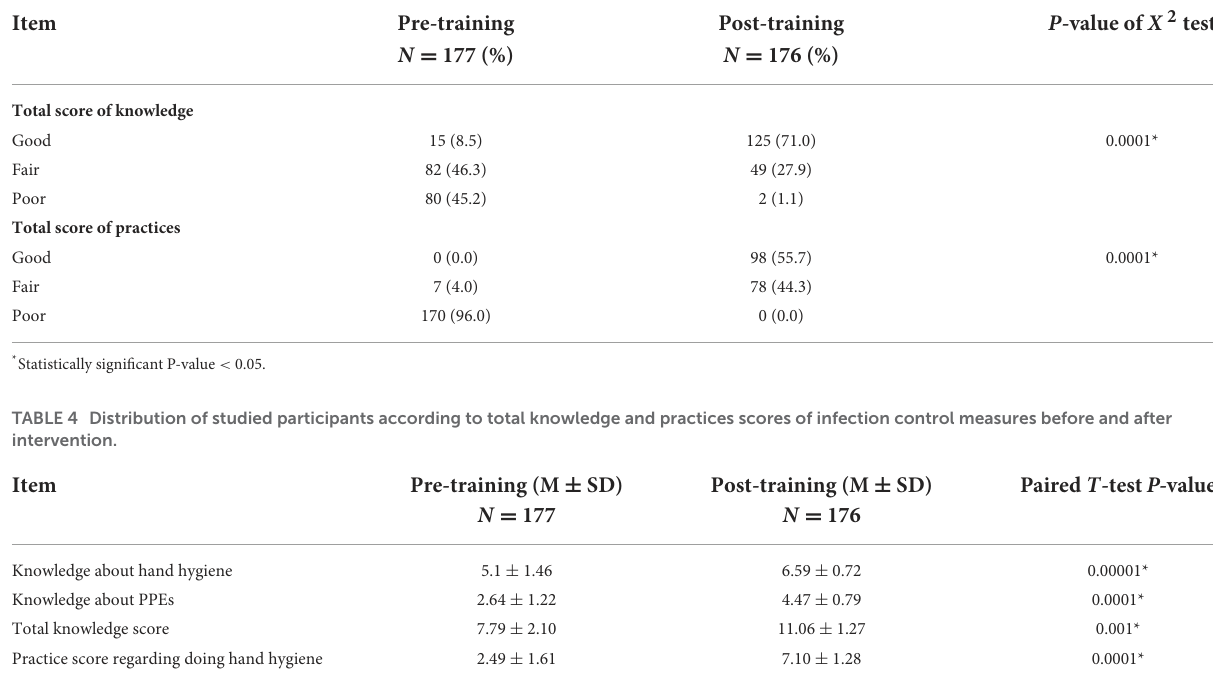
TABLE 3 Comparison between participants’ mean knowledge and practice scores of infection control measures before and after training.